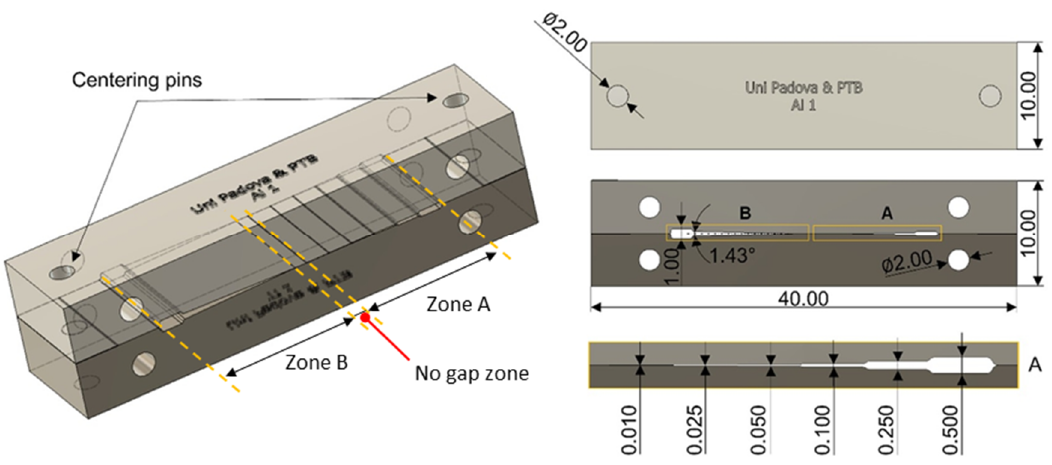
Figure 1. Multi-material gap standard. Dimensions are reported in mm.